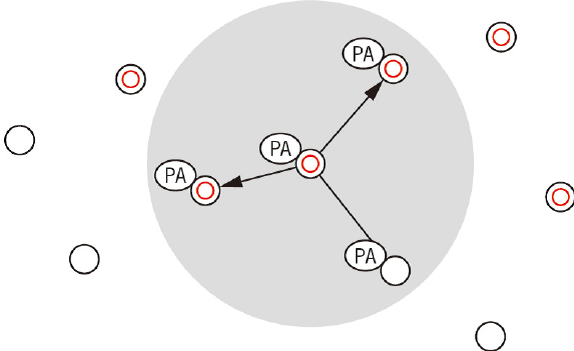
Fig. 16. (Color online) Cloned PAs move into neighboring robots. The red inner circle indicates that an AA is present.